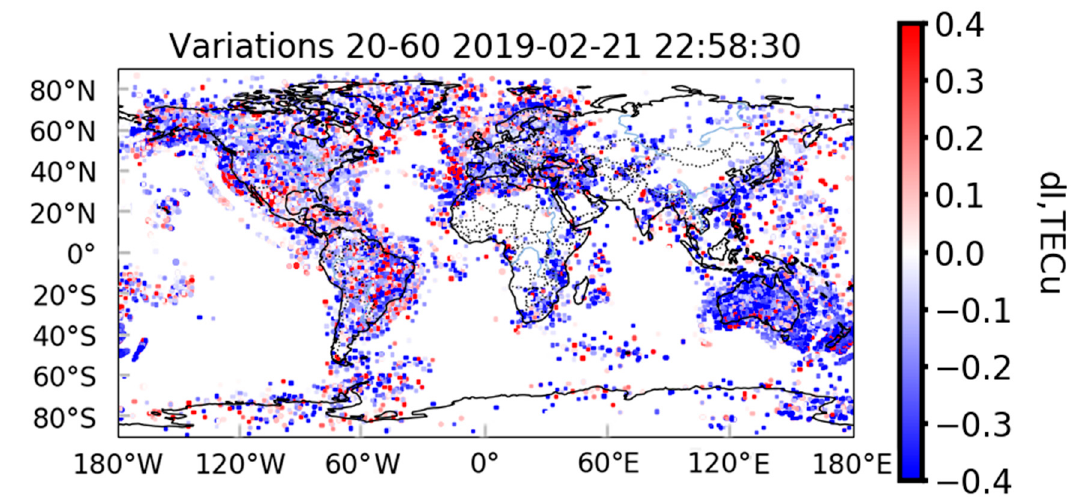
Figure 2. Map of 20–60 min TEC variation. 21 February 2019. 22:58:30 UT.